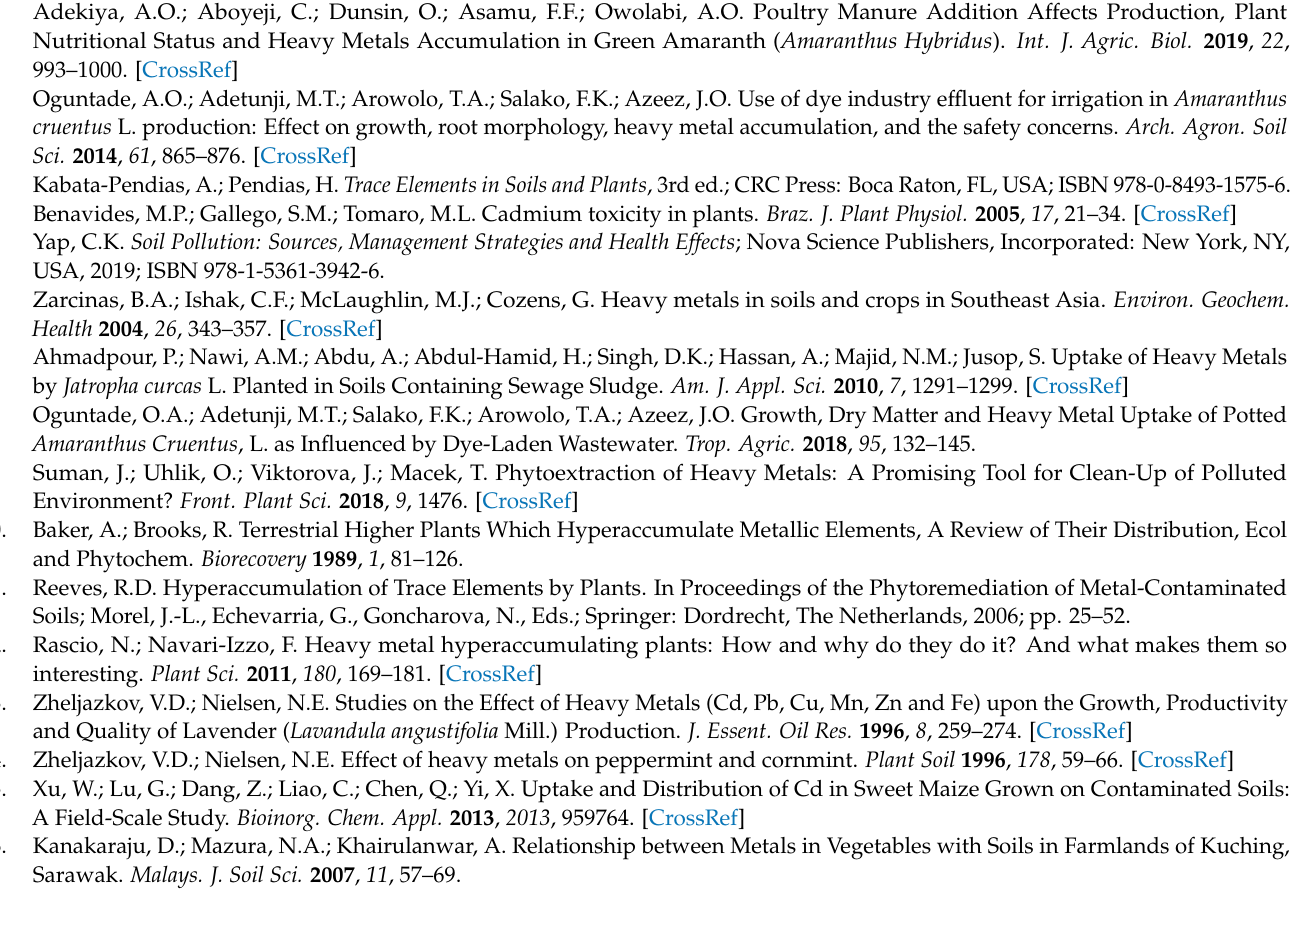
Peninsular Malaysia; Table S4: Concentration (mean ± SE, µ g/g dry weight) of Ni in the geochemical fractions of the habitat topsoils of Amaranthus viridis collected from all sampling sites in Peninsular Malaysia; Table S5: Concentration (mean ± SE, µ g/g dry weight) of Zn in the geochemical fractions of the habitat topsoils of Amaranthus viridis collected from all sampling sites in Peninsular Malaysia; Table S6: Values of estimated daily intake (EDI, µ g/kg wet weight/day) and target hazard quotient (THQ, unitless) values of Cd, Fe, Ni and Zn on the edible leaves of Amaranthus viridis from all the sampling sites in Peninsular Malaysia; Table S7: Values of bioconcentration factors (BCF) of Cd, Fe, Ni and Zn on the leaves, stems and roots of Amaranthus viridis from all the sampling sites in Peninsular Malaysia; Table S8: Values of translocation factors (TF) of Cd, Fe, Ni and Zn on the leaves, stems and roots of Amaranthus viridis from all the sampling sites in Peninsular